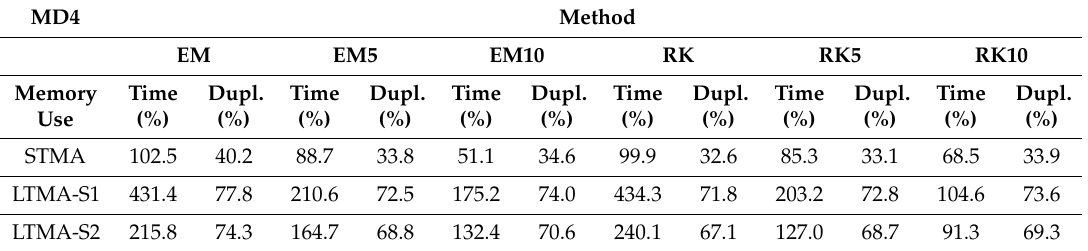
Table 33. Mean value of the calculation Times (Time) and Duplications (Dupl.) in respect to no additional memory use for 50 independent runs using EM, EM5, EM10, RK, RK5, and RK10 for